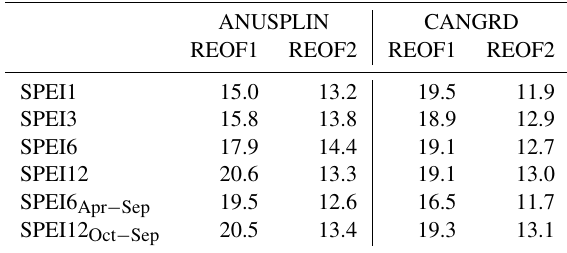
Table 3. Percentage of variance explained by the first two vari- max rotated loadings (REOFs) of the SPEI at various timescales, computed using observations from ANUSPLIN and CANGRD data